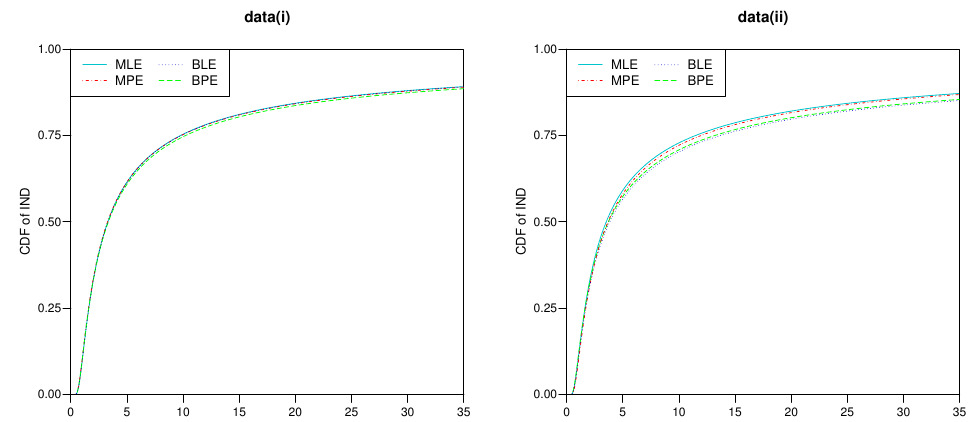
Figure 3. Plots of CDF of the IND using different estimates under data sets (i) and (ii).